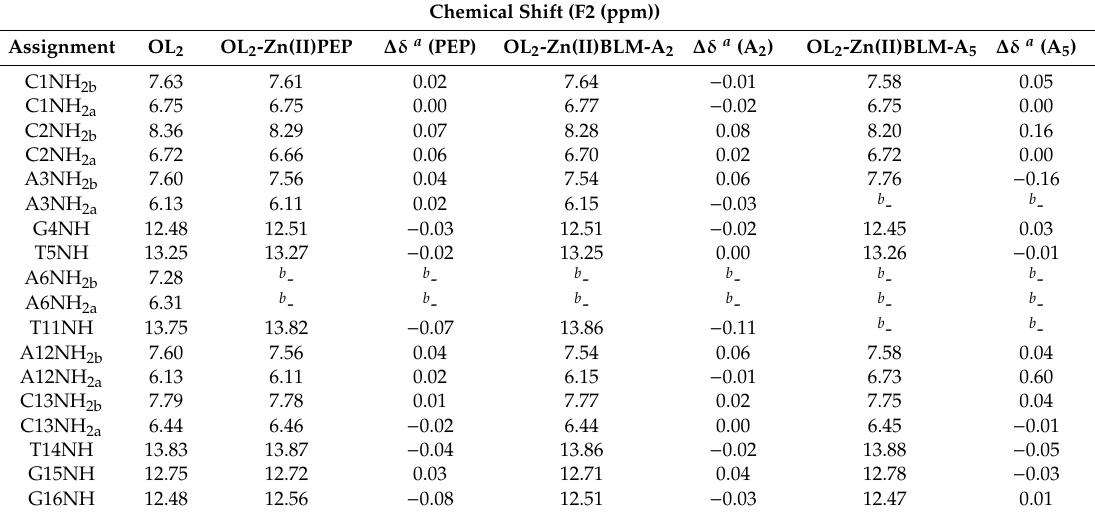
Table 1. Di ff erences in chemical shift displayed by the NH 2 and NH protons in free and metallo-BLMs (MBLM)-bound OL 2 for samples in H 2 O at 5 ◦